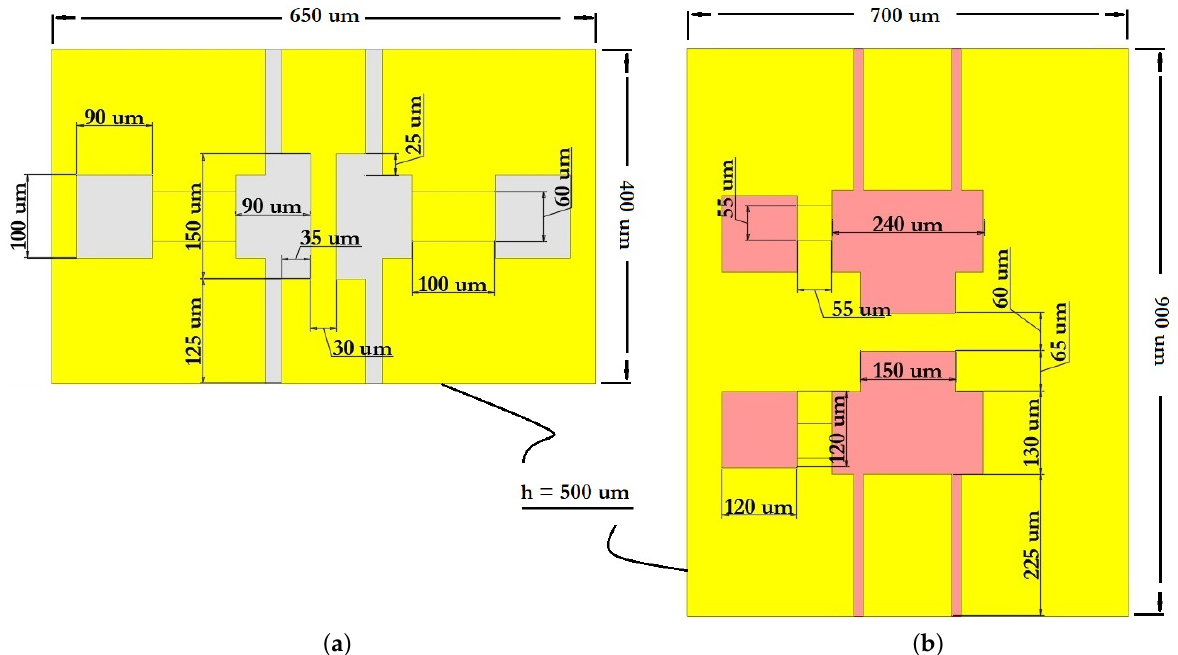
Figure 7. Schematic view: ( a ) CPW (A) is RF MEMS switch (A); ( b ) CPW (B) is RF MEMS switch (B).